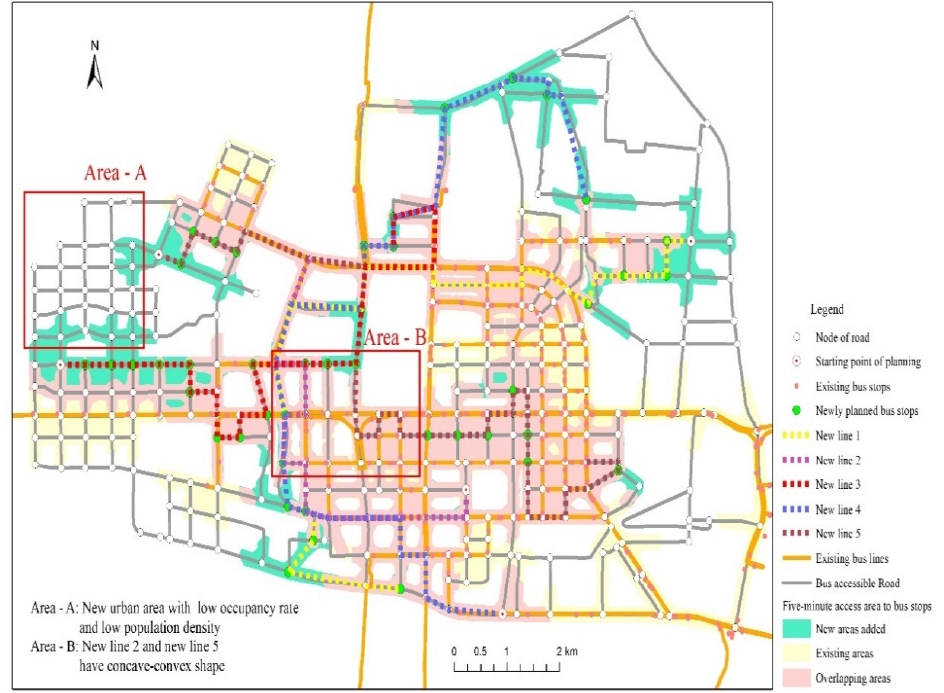
Figure 8. Optimized bus-route network distribution map of study area.